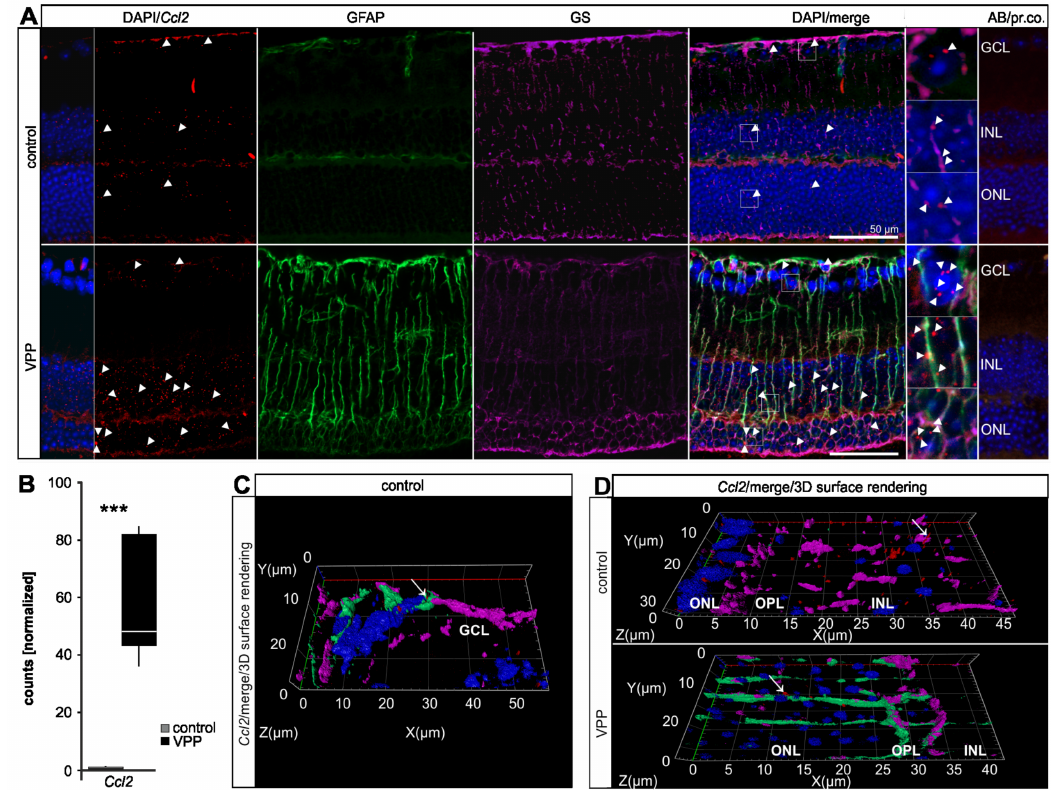
Figure 5. Upregulation of Ccl2 in VPP mice. ( A ) In situ hybridization for Ccl2 (red) and GFAP (green)/GS (purple) immunofluorescence co-labeling in the retinae of three-month-old animals. Nuclei were DAPI-stained (blue). In the control retina, a rather discrete Ccl2 signal (arrowheads) was visible. In the VPP retina, the number of the Ccl2 punctae increased (arrowheads) and the Müller cells were GFAP/GS-positive. The boxed areas in the merge image are shown in high resolution on the right. ( B ) Boxplots showing the extracted Ccl2 expression data from the RNAseq as normalized counts for control and VPP genotypes. Control n = 6; VPP n = 5; *** p adj = 8.05 × 10 − 14 . ( C , D ) Higher magnification of the GCL ( C ) and ONL/OPL/INL region ( D ) depicted as a 3D reconstruction ( Ccl2 /merge/3D surface rendering). ( C ) One of the few overlaps of the Ccl2 signals (red, arrow) with GFAP (green)-positive astrocytes. ( D ) Ccl2 punctae (red, arrow) partially overlapped with GS (purple)-positive resting (control animal, arrow) and GFAP (green)/ GS (purple)-positive reactive (VPP animal, arrow) Müller cells. GCL = ganglion cell layer; INL = inner nuclear layer; OPL = outer plexiform layer; ONL = outer nuclear layer; Ccl2 = CC-chemokine ligand 2; GS = glutamine synthetase; AB/pr. co. = antibody/probe control; AU = arbitrary